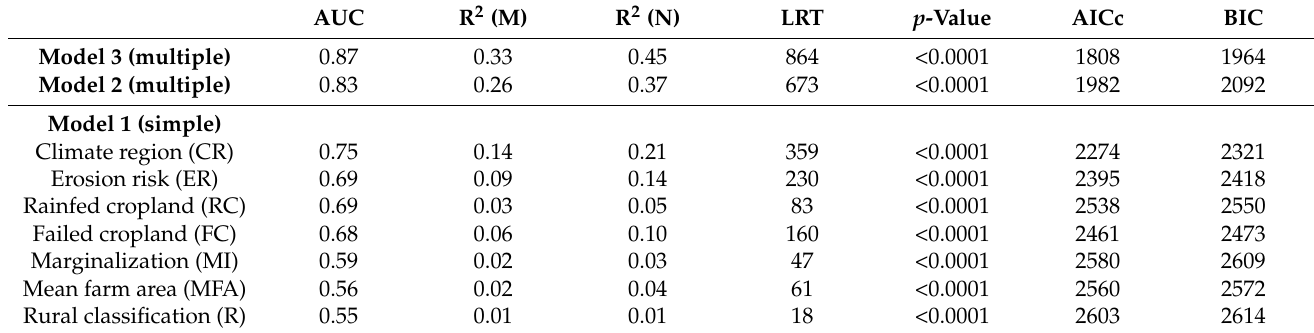
Table 2. Fit statistics for simple (Model 1) and multiple (Models 2 and 3) logistic regression models.